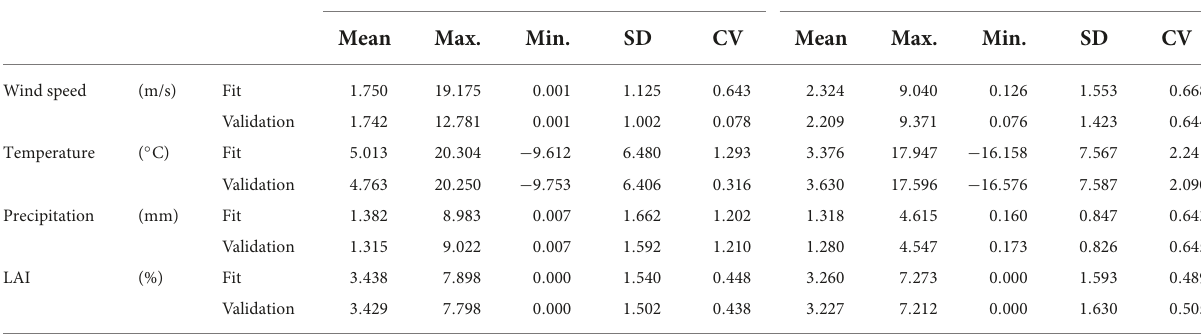
TABLE 1 Statistics of the influencing factors of forest fires. Factors Spring fire prevention period Autumn fire prevention period Mean Max. Min. SD CV Mean Max. Min. SD CV